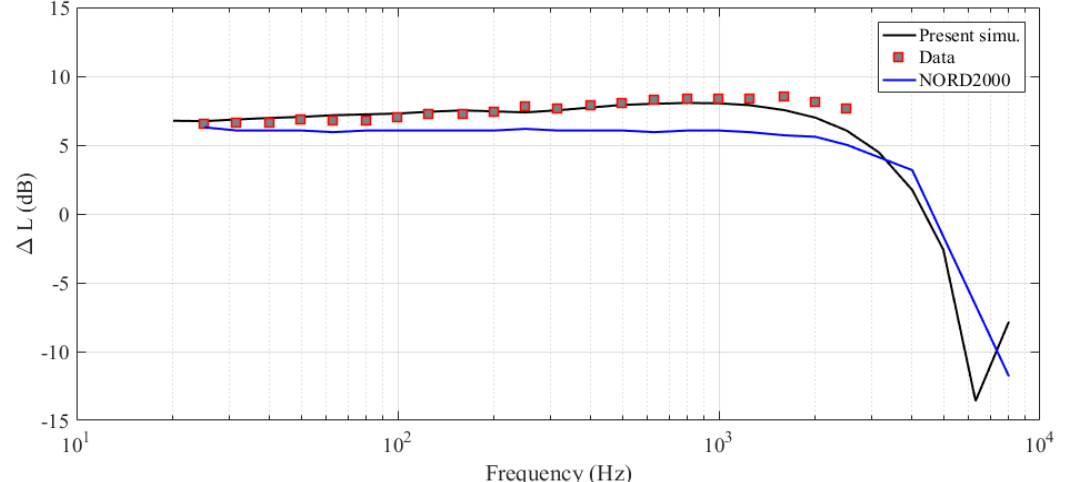
Figure 6. Comparisons of the RSPL in 1/3-octave bands at a distance of 200 m.